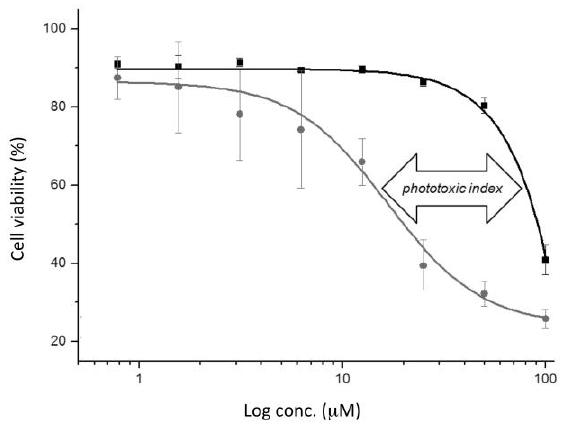
Figure 3. Dose-response curves for the anti-proliferative effect of Gd-L-Tat peptide conjugate on CAL-33 cells in the dark (black line) and upon UV-A irradiation (at 350 nm for 10 min, 2.58 J·cm −2 ; grey line).